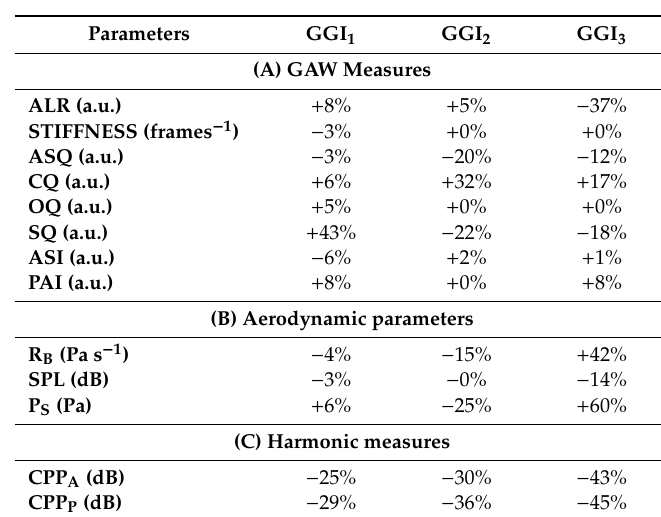
Table 7. Percentage change of this present data to normal data in corresponding GGI groups, Döllinger et al. (2018) [39].